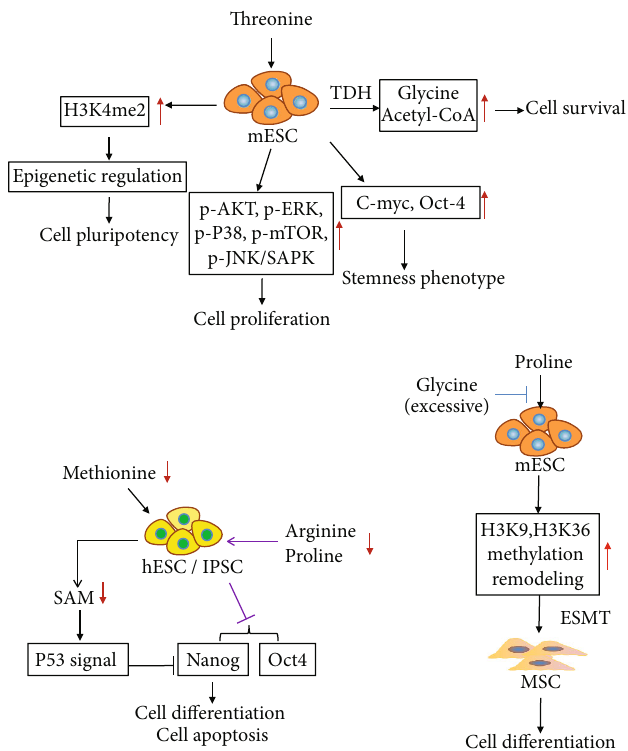
Figure 3: E ff ect of amino acids on the properties of embryonic stem cells